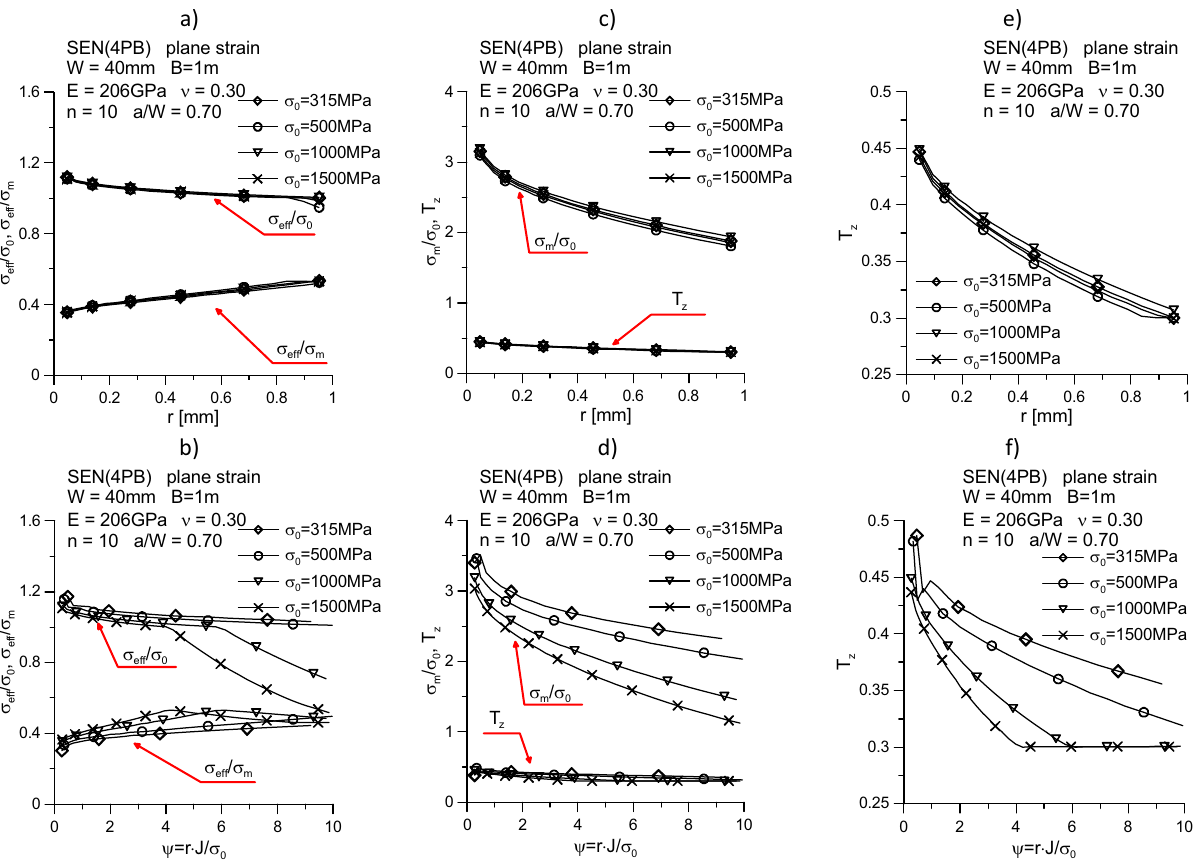
Figure 22: In fl uence of the yield point σ 0 on the distribution of parameters: σ e ff / σ 0 and σ e ff / σ m ( a and b ) ; σ m / σ 0 and T z ( c and d ) ; T z parameter ( e and f ) , near the crack tip ( graphs ( a, c, and e ) were prepared for the physical distance from the crack tip; graphs ( b, d, and f ) were prepared for the normalized distance from the crack tip ψ = r · J / σ 0 ; the charts are presented for the moment when the external load reaches the limit load value – P / P 0 = 1.00; with the following J integral values for subsequent specimens: σ 0 = 315 MPa, J = 15.6 kN/m; σ 0 = 500 MPa, J = 34.3 kN/m; σ = 1,000 MPa, J = 175.3 kN/m; σ = 1,500 MPa, J = 336.2 kN/m ) 0 0